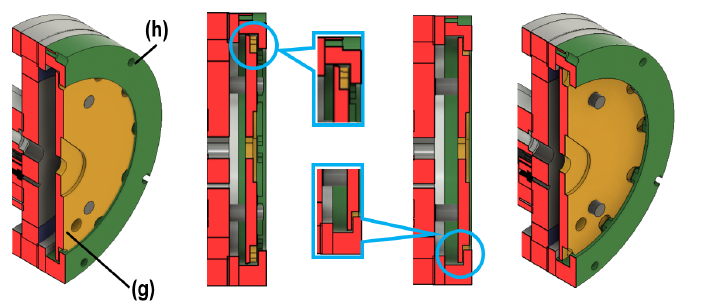
Figure 9. Details on mode switching by using clutch unit where (g) and (h) indicate the clutch disk and the clutch,